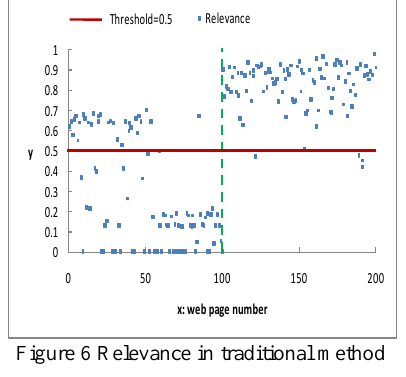
Figure 6 Relevance in traditional method